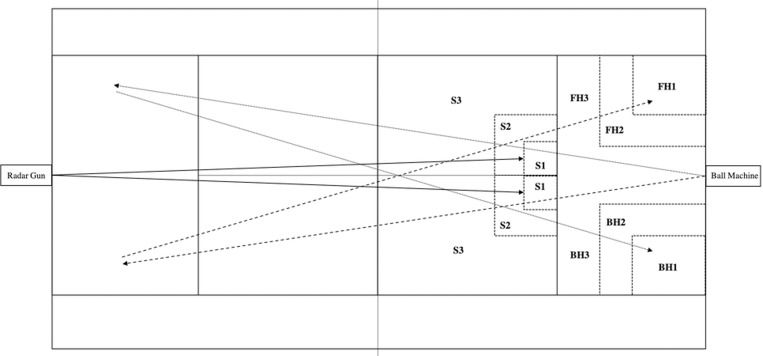
Tennis court layout for stroke velocity and accuracy assessment.S1, S2 and S3, the target areas for the serve; FH1, FH2 and FH3, the target areas for forehand drives; BH1, BH2 and BH3, the target areas for backhand drives. The full arrows indicate the ball trajectories for the serve, the dotted arrows indicate the ball trajectories for backhand drive, and the dash arrows the ball trajectories for forehand drive.